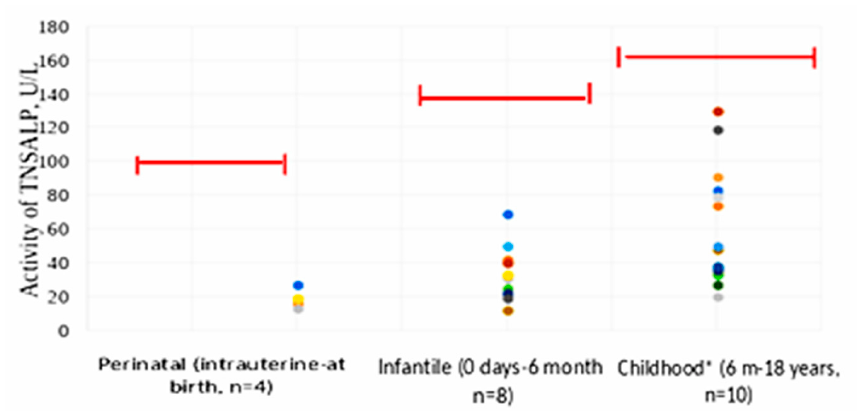
Figure 10. TNSALP activity, depending on the form of HPP in patients ( n = 22). Each colored dot in the figure explain one patient. Note: each point is one patient. Red and black indicate the lower limit of normal TNSALP at this age. *Most patients with the childhood form were diagnosed at the age of 2–9 years. The middle limit of normal was taken from the study [23].